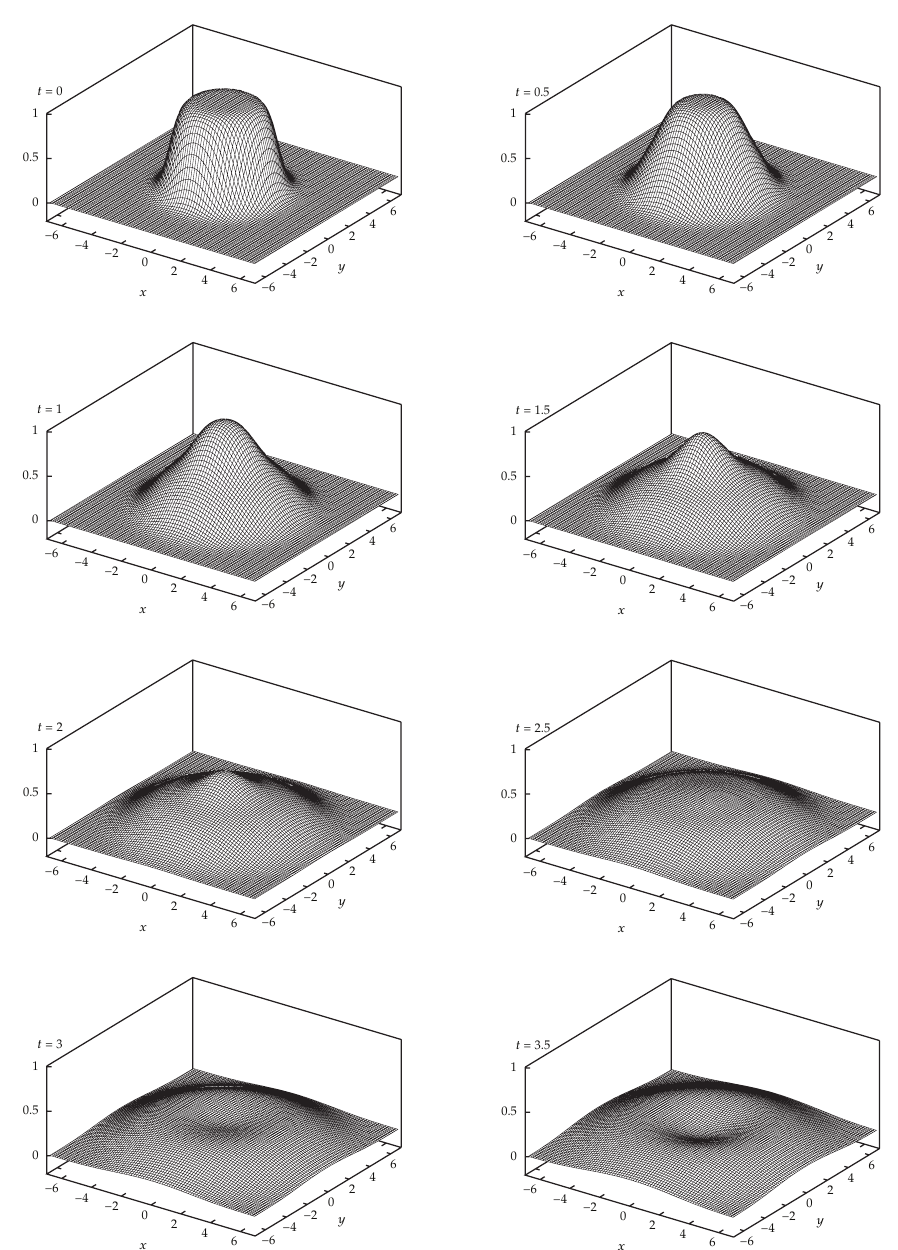
Figure 3: Numerical solution to (cid:4) 1.1 (cid:5) for α (cid:2) 1 . 5, t ∈ (cid:6) 0 , 3 . 5 (cid:7) , k ≡ 0, b ≡ 0. Closed boundary